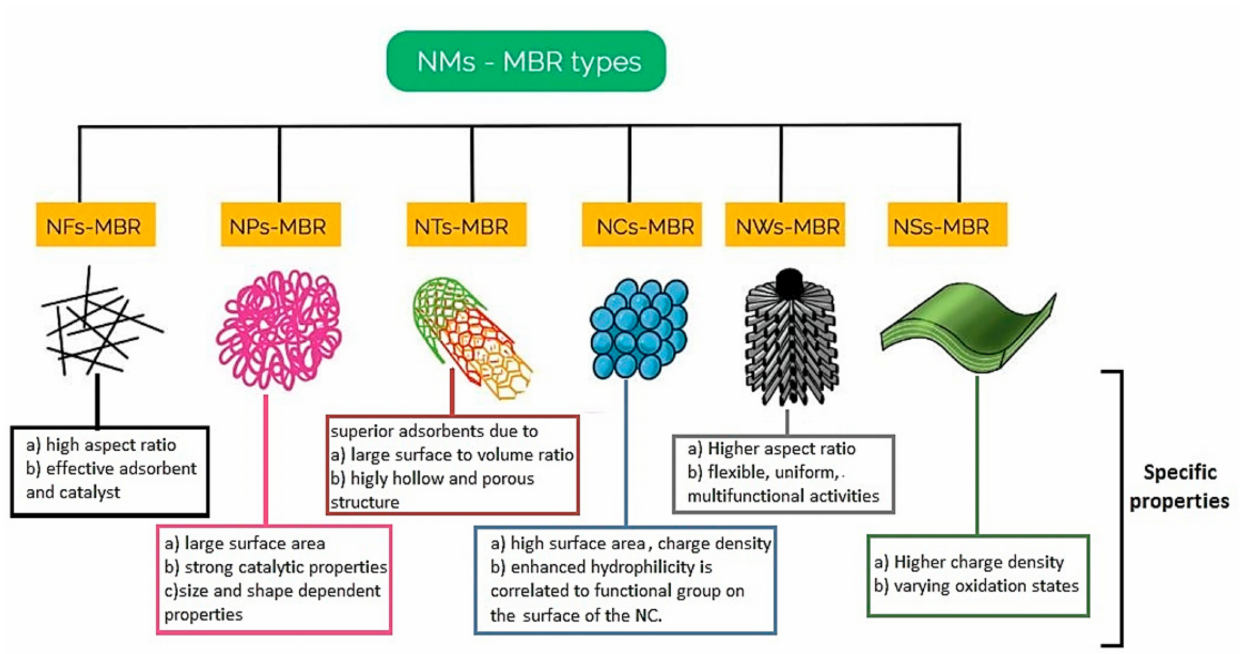
Figure 8. Types of nanomaterials of hybrid NMs-MBR systems adapted and modified from